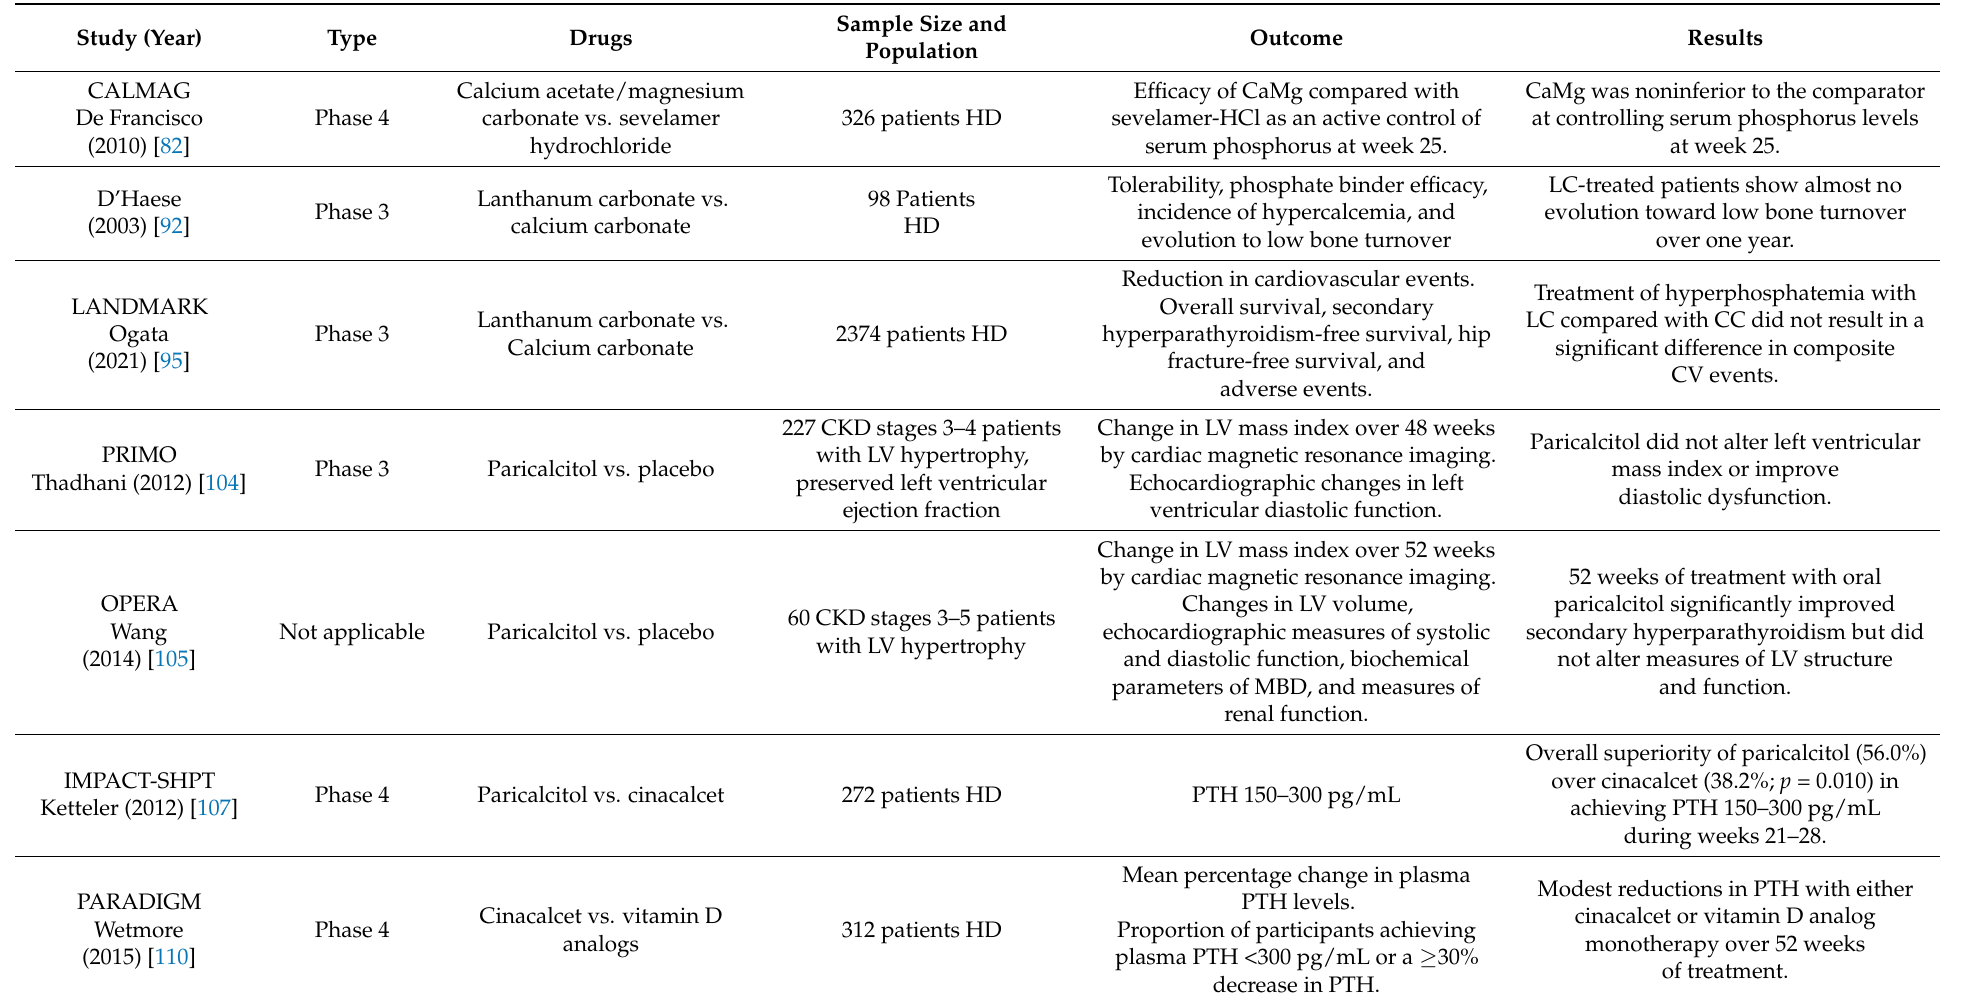
Table 2. Randomized clinical trials about different treatments acting on CKD–MBD. CaMg calcium acetate/magnesium carbonate, CKD chronic kidney disease,